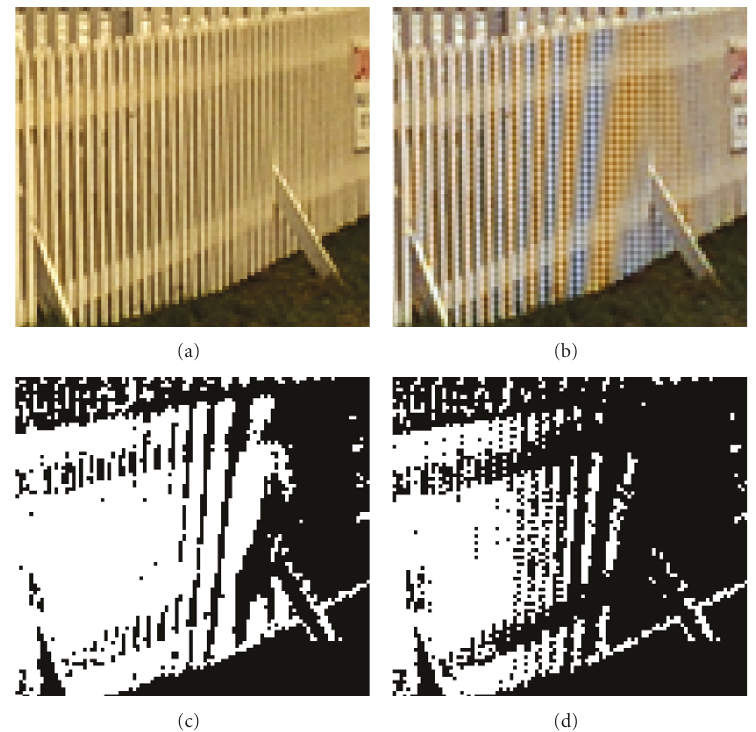
Figure 2: An example of the problem of edge detection: (a) original image, (b) color demosaicing image by method [7], (c) edge detection of original image, and (d) edge detection after color demosaicing method